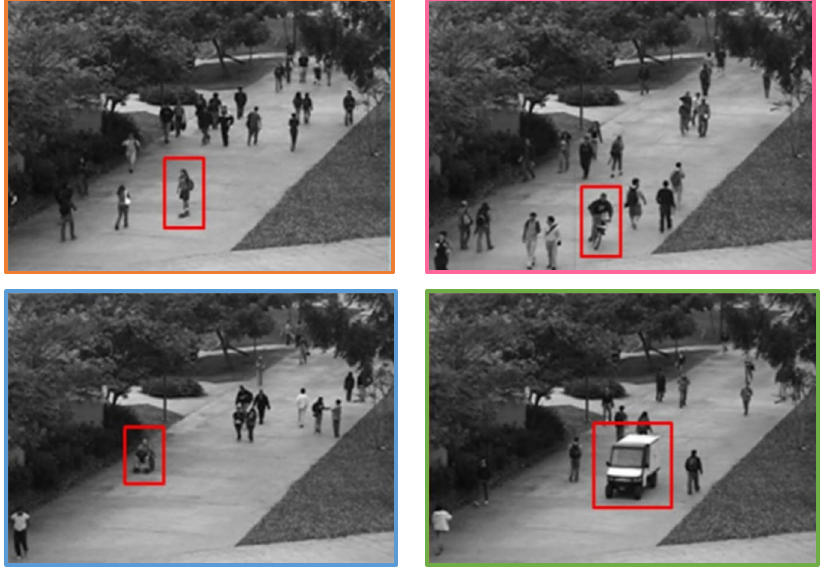
Figure 1. Abnormal Behavior.